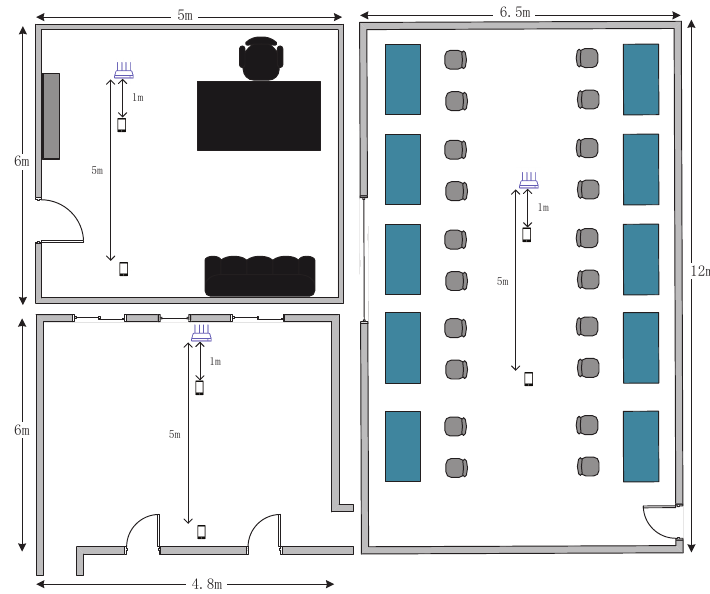
Figure 5. Layouts of three evaluation